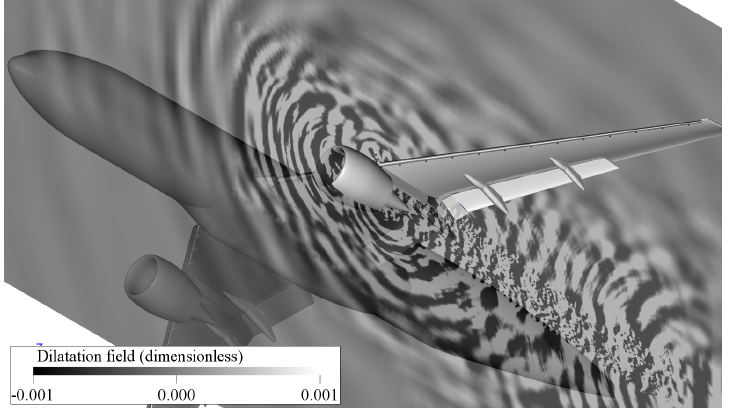
Figure 16. The contour of the dilatation field (time derivative of pressure) surrounding the nacelle containing the SDT fan stage (baseline configuration). Note that the dilatation field is expressed in nondimensional